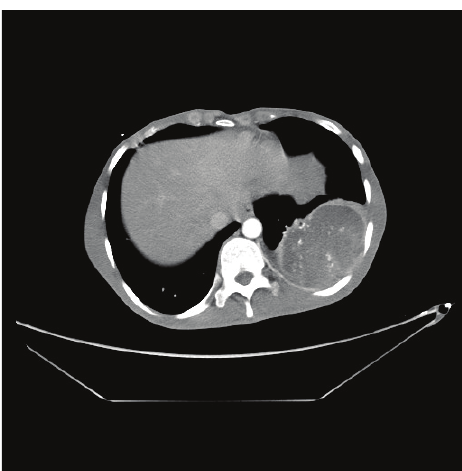
Figure 1: Abdominal computed tomography scan revealed renal metastases of osteosarcoma.